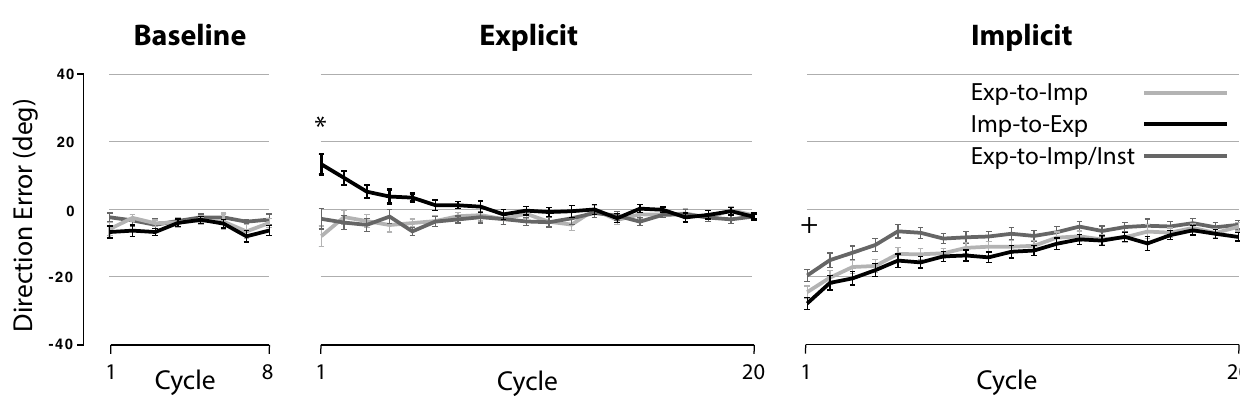
Fig 4. Changes in performance (mean ± SE) across cycles in Exp-to-Imp, Imp-to-Exp and Exp-to-Imp/Inst groups. Each data point represents mean DE across six consecutive trials (cycle). Performance changes across cycles for Exp-to-Imp, Imp-to-Exp and Exp-to-Imp/Inst groups during baseline (left), explicit (middle), and implicit (right) conditions are shown separately. � indicates significant difference between Imp-to-Exp and Exp-to-Imp groups and also between Imp-to-Exp and Exp-to-Imp/Inst groups, p < .05. + indicates significant difference between Imp-to-Exp and Exp-to-Imp/Inst groups, p < .05.